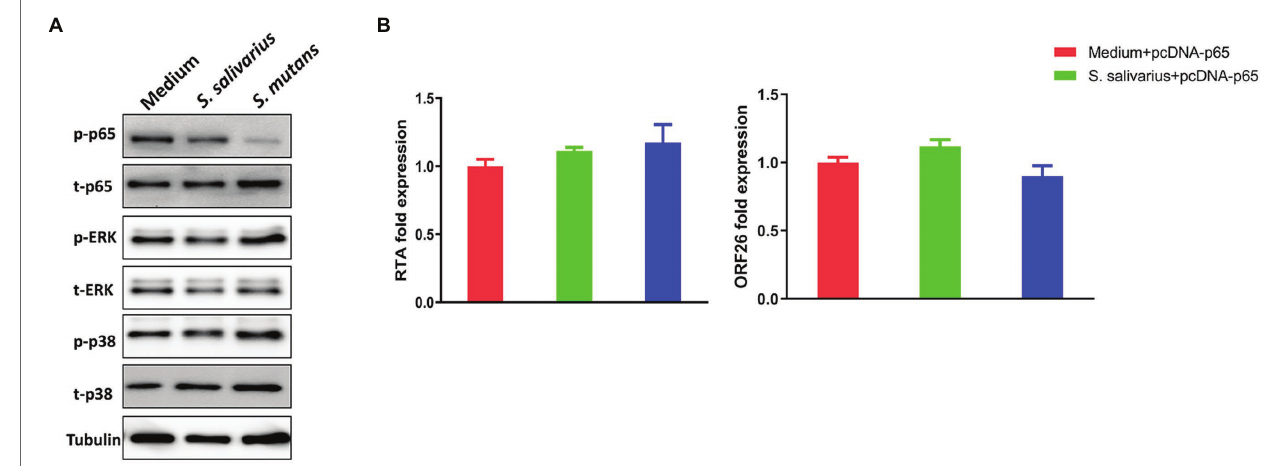
FIGURE 7 | NF- κ B signaling pathway is involved in Streptococcus species induced KSHV lytic reactivation. (A) PDLF and HGF were infected and treated as described above, and then protein expression was detected by using Western blot. (B) PDLF cells were infected first, then transfected with a recombinant construct encoding NF- κ B p65 for 48 h, and treated with filtered conditioned medium from Streptococcus species culture for additional 48 h. Viral gene expression was quantified using qRT-PCR. Error bars represent the SD for three independent